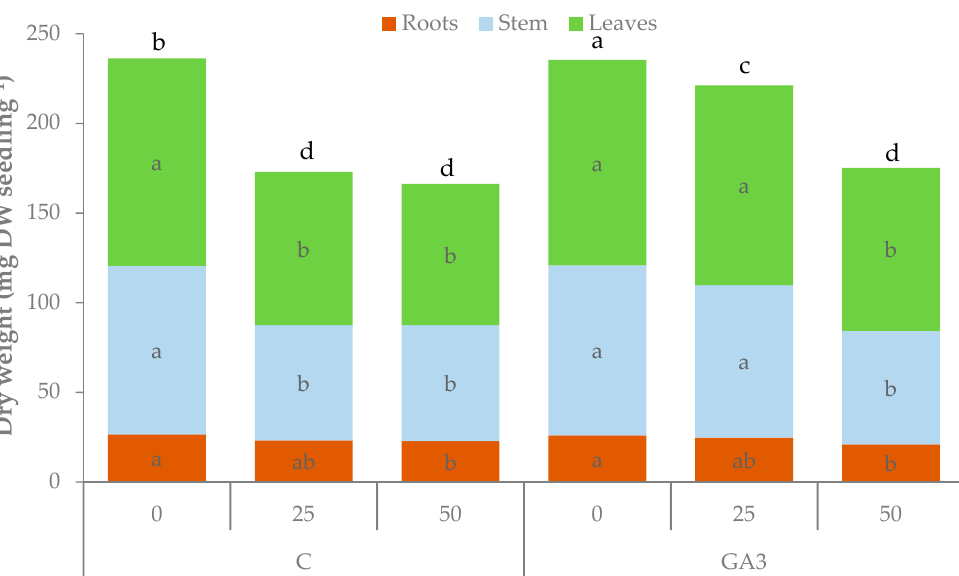
Figure 5. Effect of the seedling treatments (C, untreated control, GA3, gibberellic acid spray 10 − 5 M) and salt stress (0, 25, and 50 mM NaCl in the irrigation water) on the total, root, stem, and leaf dry weight of tomato seedlings. Bars of the same color with different letters are significantly different at p < 0.05 according to the LSD test).